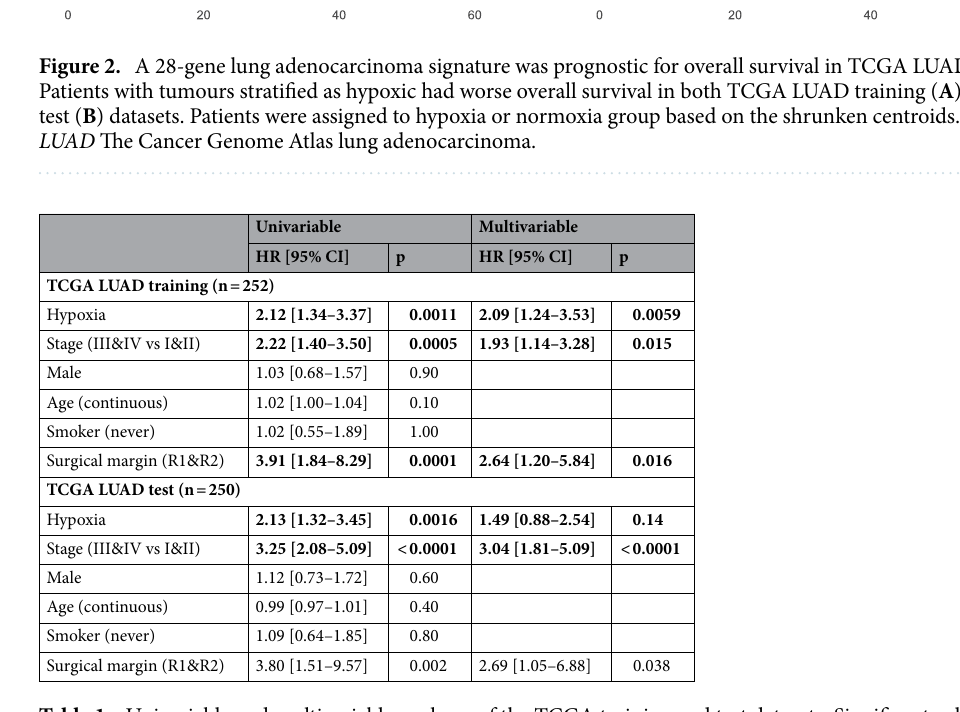
Table 1. Univariable and multivariable analyses of the TCGA training and test datasets. Significant values are in bold.